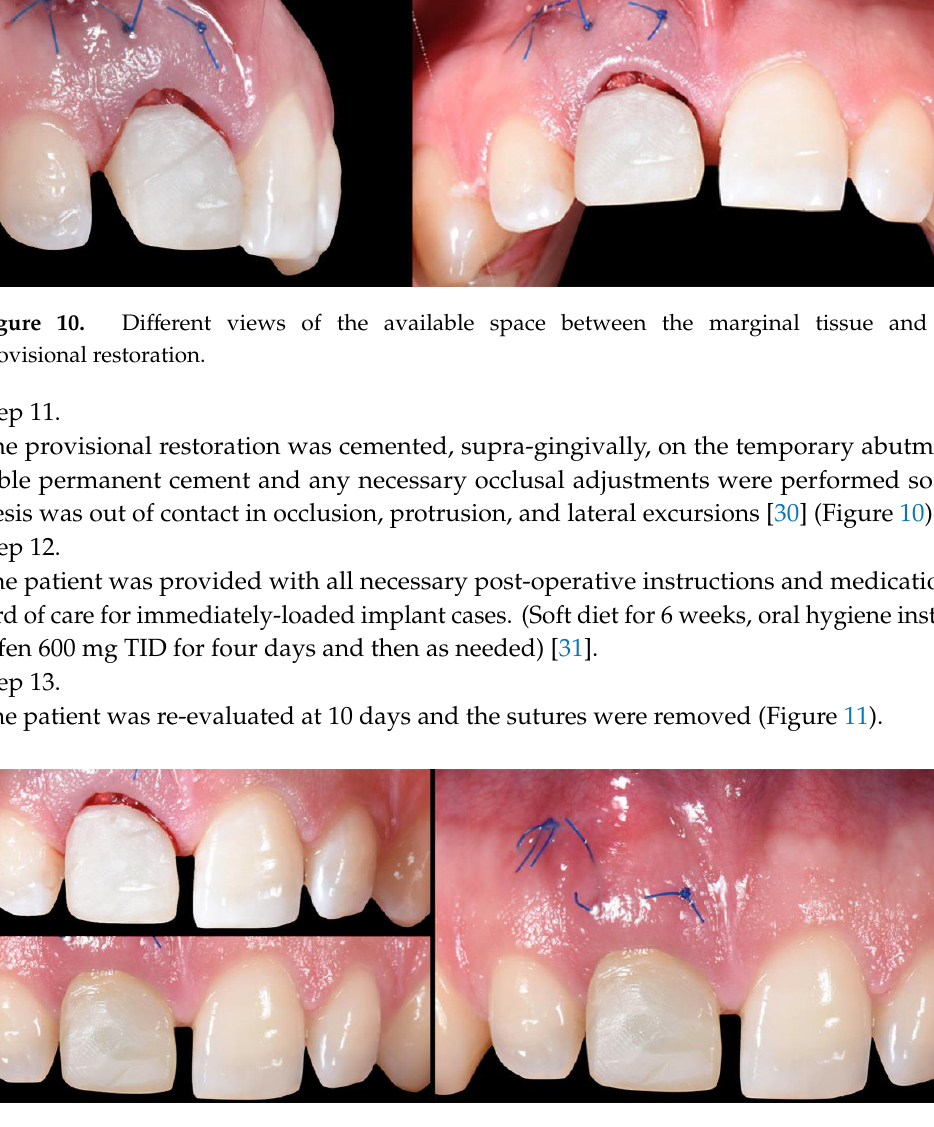
Figure 11. First re-evaluation. Comparison of pre-op and current adaptation of the soft tissue, where marginal migration in a coronal direction is evident.